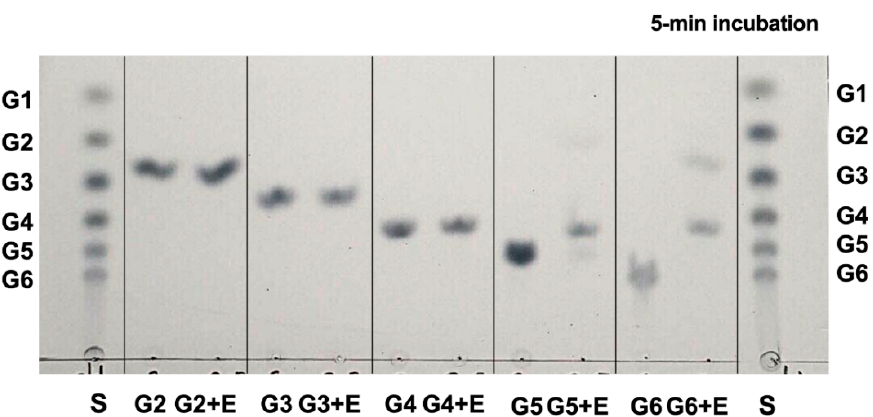
Figure 5. TLC analysis of hydrolysis products generated by 0.25 µM Calk GH9T using cellodextrins with a degree of polymerization of 2–6 (G2–G6) as the substrates for 5-min incubation. S, standards of glucose and cellodextrins with a degree of polymerization of 2–6 (G2–G6). E, Calk GH9T. G2, G3, G4, G5, and G6 represent a reaction control (a reaction mixture containing a substrate and a dena- tured enzyme). G2 + E, G3 + E, G4 + E, G5 + E, and G6 + E represent enzymatic reactions. The enzy- matic reactions were performed at pH 7.4 and 55 °C.